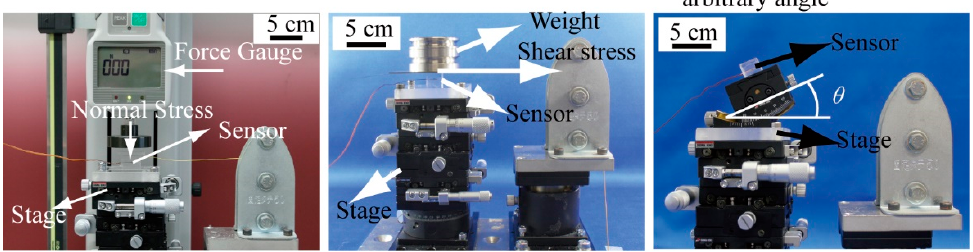
Figure 11. Photograph of the experimental setups. ( a ) setup to calibrate normal stresses, ( b ) setup to calibrate shear stresses,